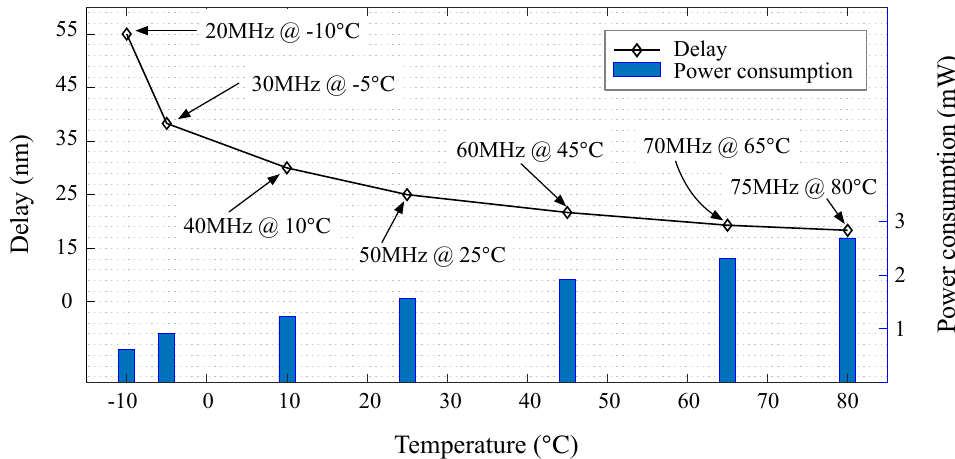
Figure 8. Measured result of scalable frequency and corresponding power consumption of the prototyping processing unit at each temperature point when TEI-FS is employed and V dd = 0.48